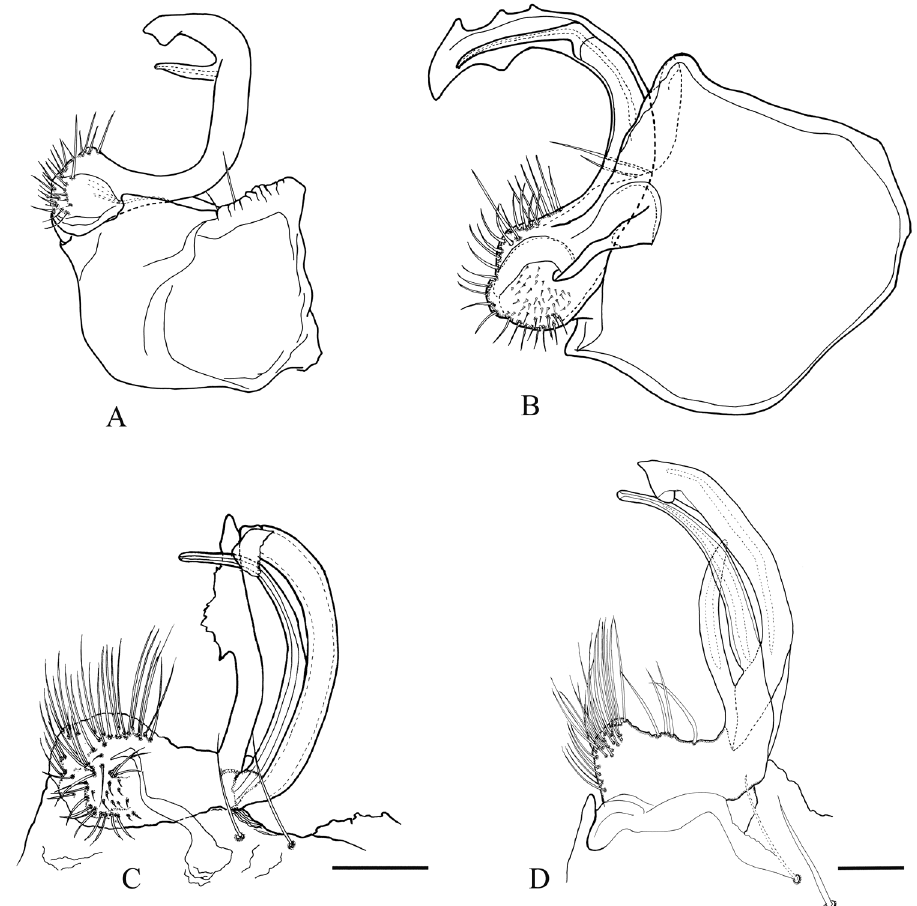
Figure 5. North African Trichopolydesmidae, right gonopod in postero-lateral view: A Haplocookia mauritanica Brölemann, 1915 (redrawn after Brölemann 1915) B Haplocookia franzi Schubart, 1960 (redrawn after Schubart 1960) C Heterocookia novator (Silvestri, 1896) D Heterocookia tunisiaca Ceuca, 1967. Scale bar 0.1